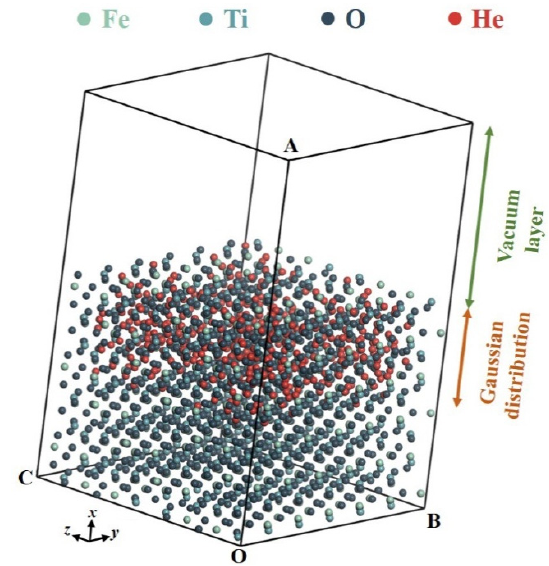
Figure 2. Geometric model of helium-3 atoms in ilmenite with Gaussian distribution for molecular dynamics simulations.